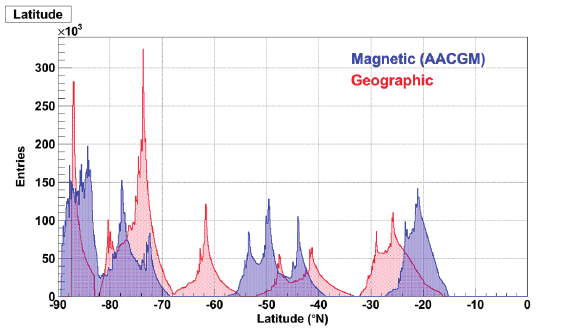
Figure 4. Distribution of geographic latitude (red) and Altitude Ad- justed Corrected Geomagnetic Latitude (AACGM) at the altitude of 350 km (blue) for the considered